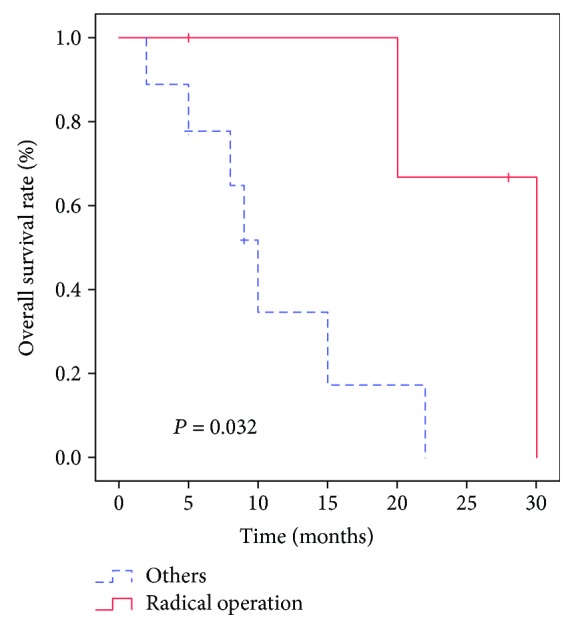
Prognostic values of radical operation in primary hepatic neuroendocrine carcinomas. The survival curve shows that the total survival rate of the radical operation group was higher than that of the other group (p < 0.05).